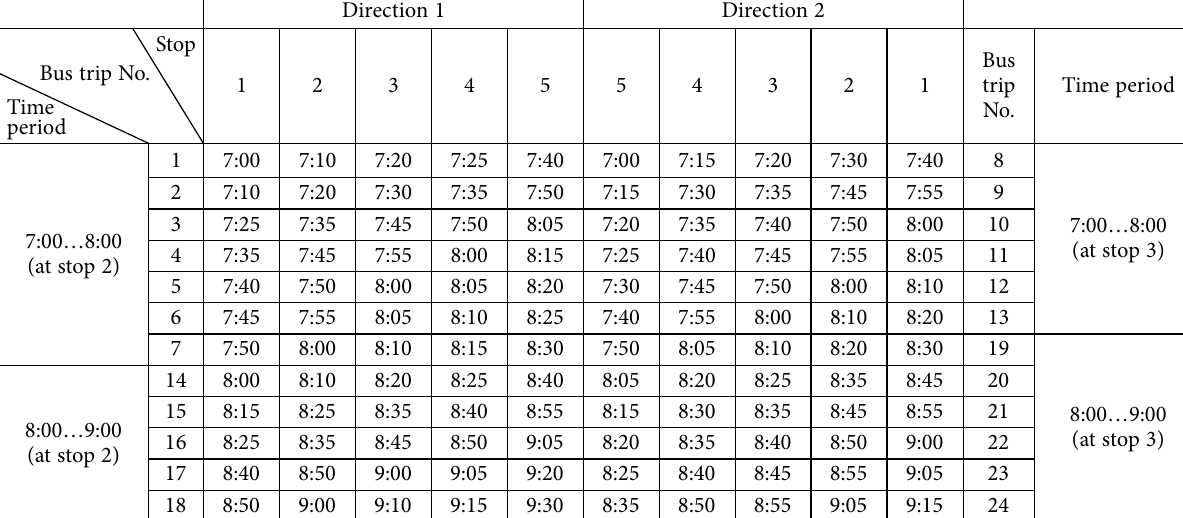
Table 2. Timetable during two-hour